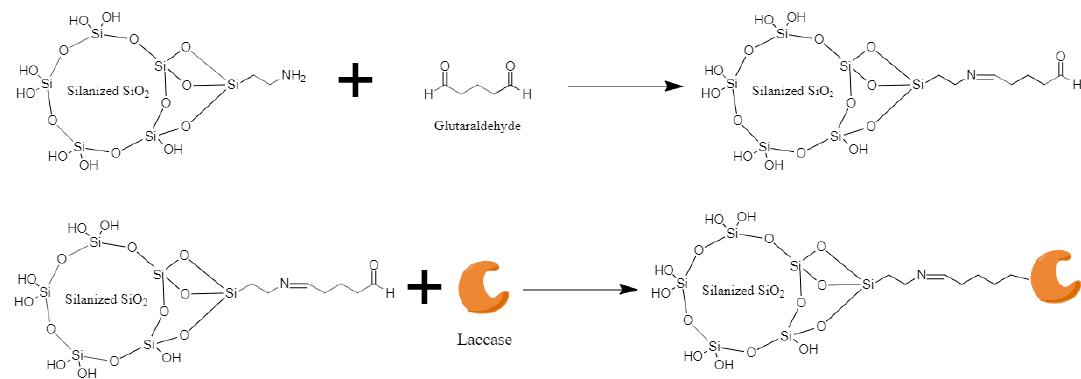
Figure 1. Reaction mechanism for enzyme immobilization. Upper panel shows the activation of NH 2 terminal groups silanized silica nanoparticles with the aid of glutaraldehyde. Bottom panel shows the conjugation of laccase by forming imine bonds with the pre-activated silica nanoparticles.